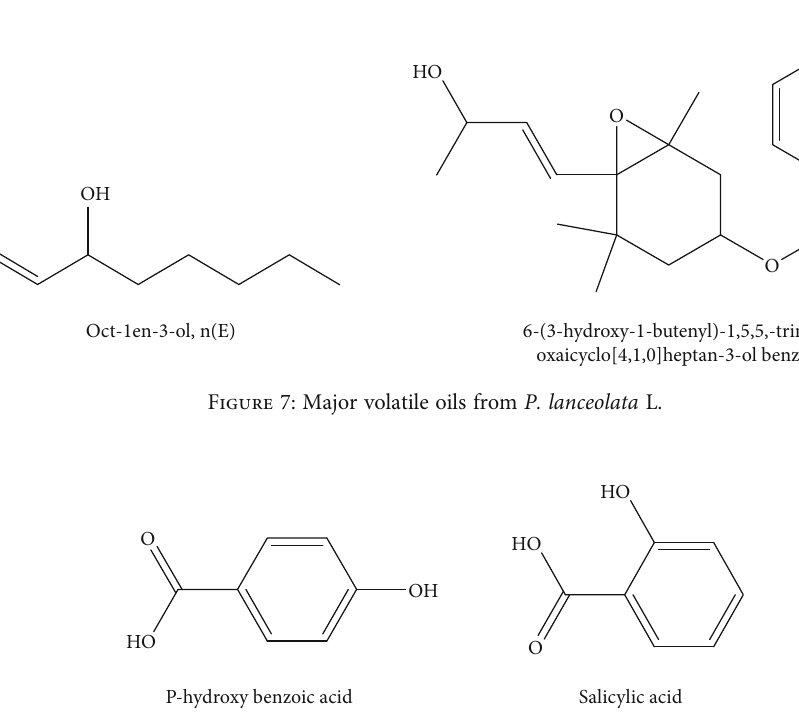
Figure 8: Some phenolic compounds from P. lanceolata